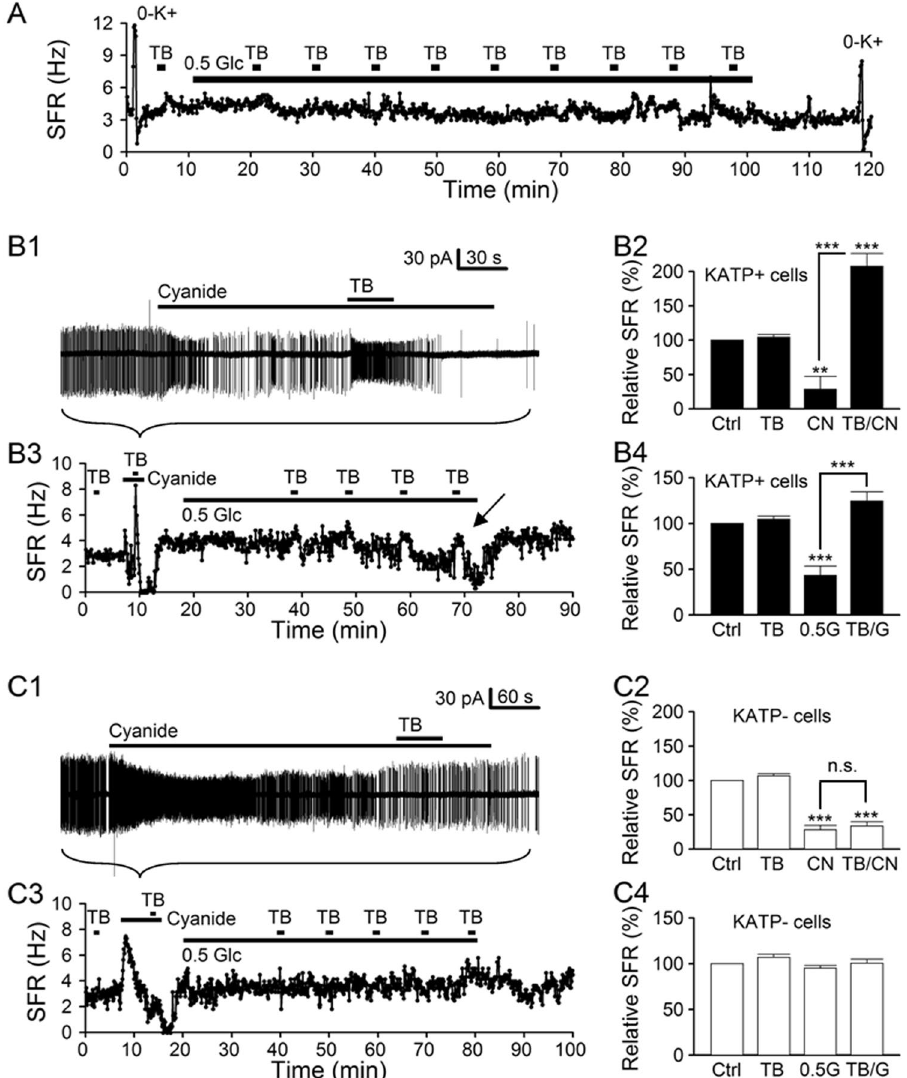
Figure 7. Hypoglycemia selectively inhibits the K ATP -expressing SCN neurones. ( A ) A representative dSCN neurone showing a negligible response to the application of hypoglycemic (0.5 mM glucose) solution for 90 min. K + -free (0-K + ) solution was applied to evaluate the cell condition (see Results for details). Daytime recordings (ZT 8). ( B ) Firing responses of K ATP -expressing (KATP + ) cells to cyanide (B1,B2) and to 0.5 mM glucose solution (B3,B4). For this representative KATP + cell, the addition of cyanide rapidly increased and then decreased the firing rate (B1), with tolbutamide (TB) having little effect on firing rate in control (Ctrl) but greatly increasing it during cyanide inhibition (B1,B3). Daytime recordings (ZT 7). Statistics showing that cyanide (CN, B2) or hypoglycemia (0.5 G, B4) inhibits KATP + cells by opening tolbutamide-sensitive K ATP channels (TB/CN, B2; TB/G, B4). Baseline spontaneous firing rate in KATP + cells: 3.2 ± 0.4 Hz ( n = 11). ( C ) Firing responses of KATP– cells to cyanide ( C1,C2 ) and to 0.5 mM glucose solution (C3,C4). For this representative KATP– cell, the addition of cyanide rapidly increased but then slowly decreased the firing rate (C1), with tolbutamide (TB) having little effect on firing rate in control and during cyanide inhibition (C1,C3). Nighttime recordings (ZT 14). Statistics showing that cyanide inhibits KATP– cells by mechanisms other than opening tolbutamide-sensitive K ATP channels (C2) and that hypoglycemia (0.5 G) had no effect on KATP– cells for up to 1 hr (C4). Baseline spontaneous firing rate in KATP– cells: 3.6 ± 0.2 Hz ( n = 9). ** P < 0.01, *** P <